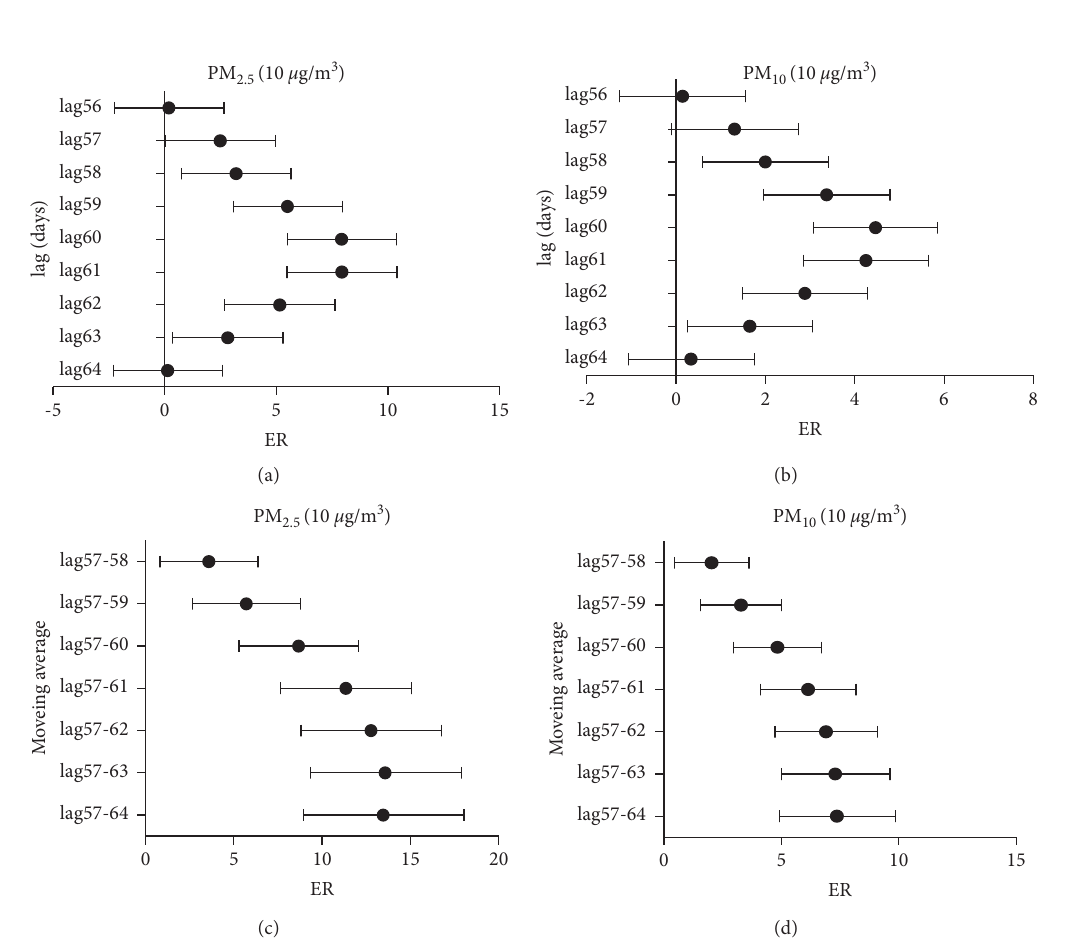
Figure 2: Excess risk (ER) and 95% confidence interval (CI) in daily hypertension hospital admissions per 10 μ g/m 3 increase in PM 2.5 at different lag days: (a) excess risk (ER) in daily hypertension hospital admissions per 10 μ g/m 3 increase in PM 2.5 , in single-day lag 56–64 days; (b) excess risk (ER) in daily hypertension hospital admissions per 10 μ g/m 3 increase in PM 10 , in single-day lag 56–64 days; (c) excess risk (ER) in daily hypertension hospital admissions per 10 μ g/m 3 increase in PM 2.5 , in moving average since 57 days; and (d) excess risk (ER) in daily hypertension hospital admissions per 10 μ g/m 3 increase in PM 10 , in moving average since 57